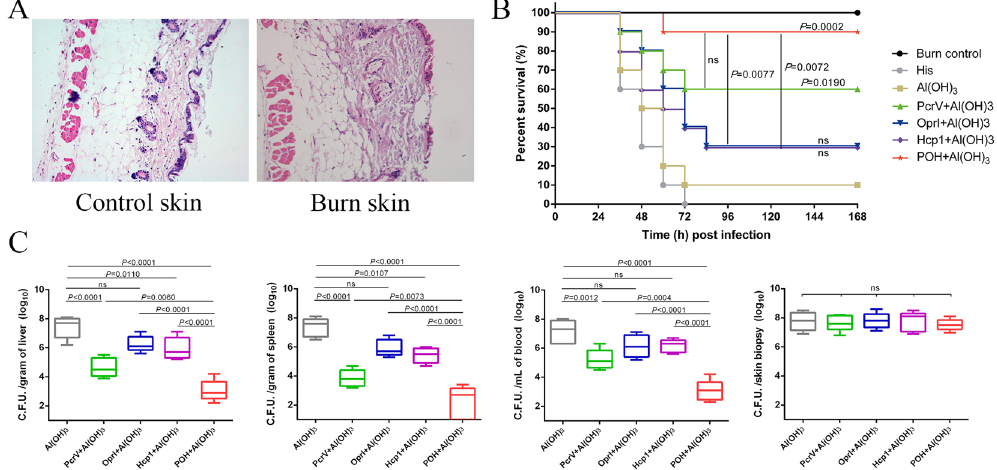
Figure 4. Protective effect of POH in a mouse burn model infected with P . aeruginosa . ( A ) Histopathology of the burned skin. Compared with the control unburned skin, the burn zone without nuclei included the whole epidermis and dermis (magnification = 200X). ( B ) Survival rates of immunized mice (n = 10) challenged with burn wound infections by P . aeruginosa strains PAO1. Two weeks after the final immunization (POH, PcrV, OprI, and Hcp1), the immunized mice and control mice (n = 10) were burned and subsequently challenged with PAO1 (300 CFUs for each). Survival was monitored twice daily for 7 days, and the rates were analyzed using the log-rank test method. ( C ) Effects of immunization with POH, PcrV, OprI, and Hcp1 on the local and systemic spread of P . aeruginosa strains inoculated into the burned skin. The bacterial load was determined in the liver, spleen, blood and skin (n = 10). Values represented as the mean ± SD. Differences were compared to determine their statistical significance using Student’s t-test (ns = no significance).